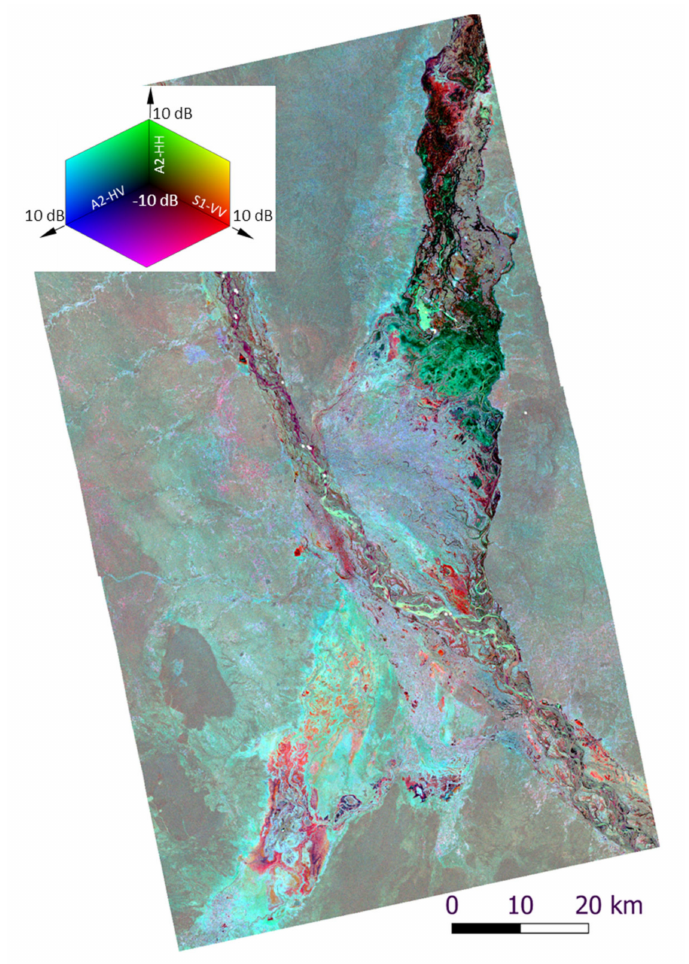
Figure 12. Multifrequency RGB (red-green-blue) intensity ratio combination: red—S1-VV change, green—A2-HH change, blue—A2-HV change. Input values are saturated at ± 10 dB, as illustrated by the inset color